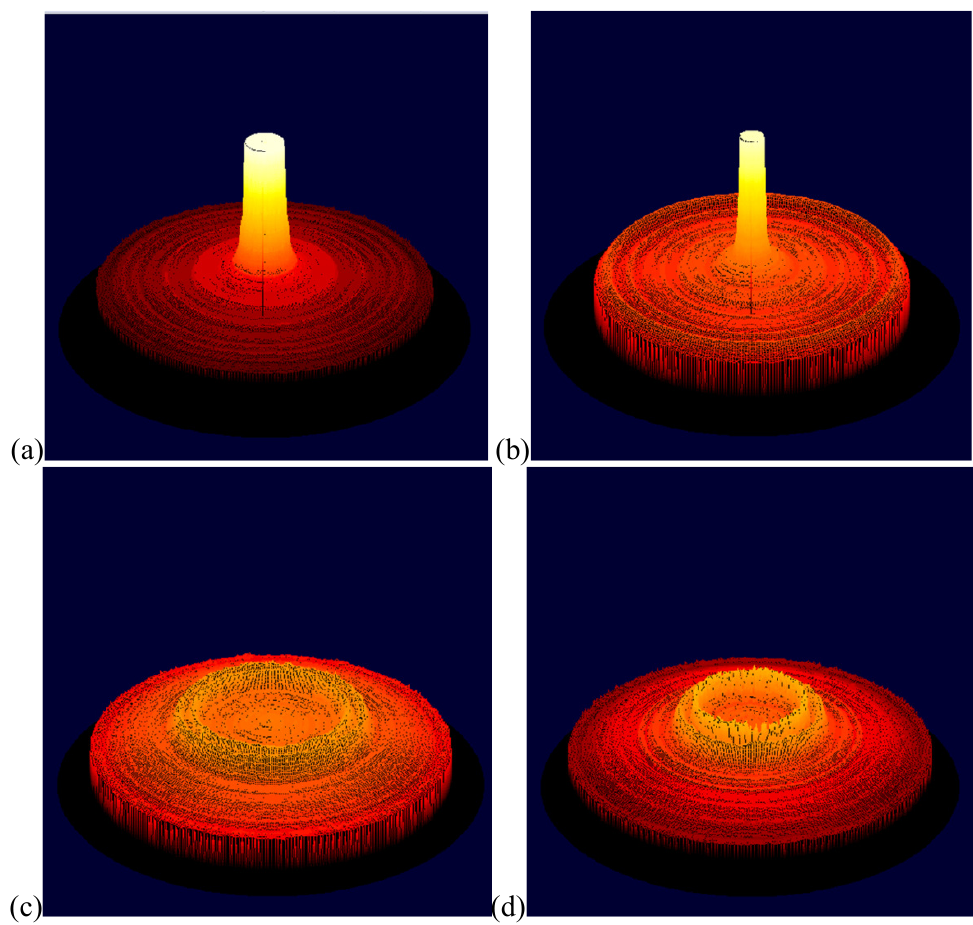
Figure 3. Three-dimensional surface plots of the pole figures (constructed by